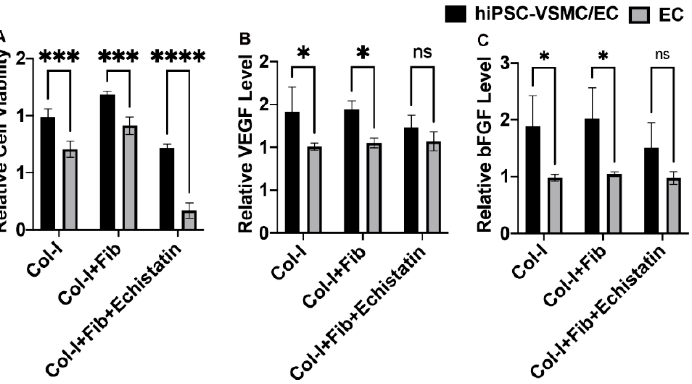
Figure 6. Characterization of cell viability and paracrine secretion. ( A ) The AlamarBlue assay shows the relative viability of the HUVEC and co-culture hydrogels. ELISA data showing relative secretion of relative levels of growth factors ( B ) VEGF, and ( C ) bFGF. The hydrogel groups were collagen hydrogel (Col-I), fibronectin functionalized collagen hydrogels (Col-I + Fib), and echistatin treated Col-I + Fib hydrogels (Col-I + Fib + Echistatin). * denotes statistical significance differences between the different groups ( n = 3; one-way ANOVA, * p < 0.05; *** p < 0.001).